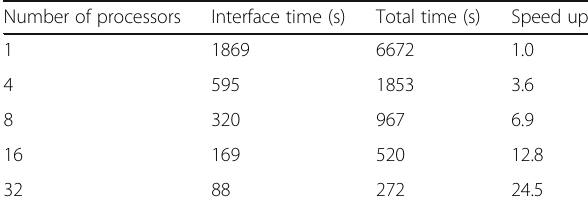
Table 2 Time used for the FETI-DP and parallel speedup for calculating the optical force of the nanosphere dimer system with 32 subdomains and 3.5 million unknowns